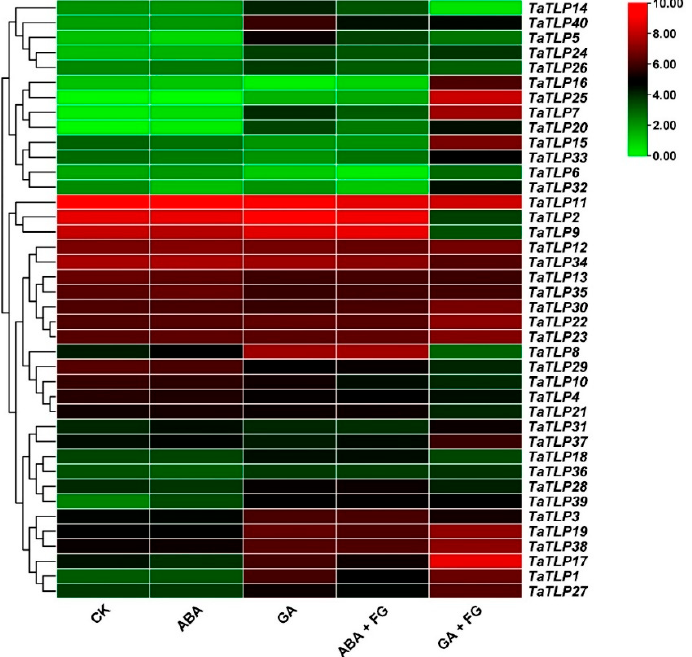
Figure 8. Heatmap represents expression analysis of TaTLP genes in wheat subjected to hormonal treatment and hormones + Fusarium graminum. ABA (abscisic acid), GA (gibberellic acid), ABA+FG (abscisic acid + Fusarium graminum ) , GA + FG (gibberellic acid + Fusarium graminum ).